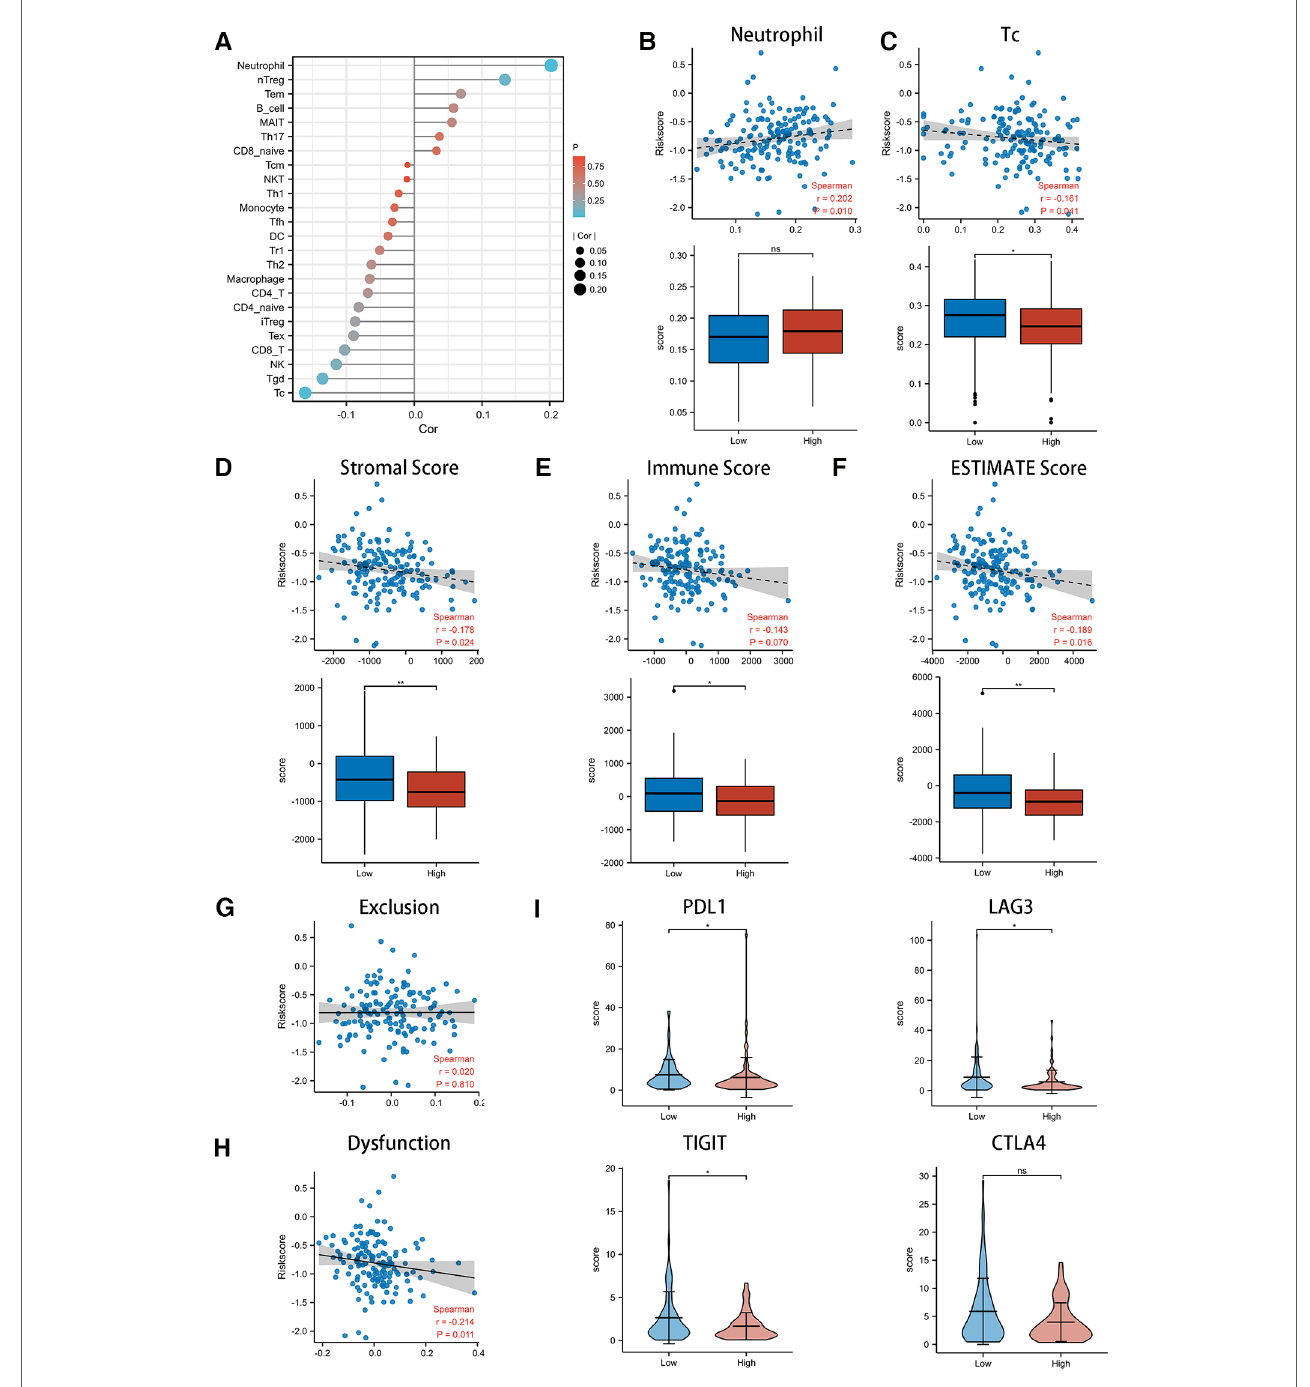
FIGURE 5 Exploring the role of CSRS in the immunotherapy of esophageal cancer. ( A ) Correlation of CSRS with immune cell in fi ltration was performed by ssGSEA analysis. High CSRS group were in fi ltrated by more neutrophil ( B ) and fewer Tc( C ). Relationship between scores with CSRS, as well as comparison of scores between high- and low-CSRS group in stromal ( D ) score, immune ( E ) score and ESTIMATE ( F ) score. Relationship between exclusion ( G ) and dysfunction ( H ) scores with CSRS. ( I ) Comparison of checkpoint genes, including PDL1, LAG3, TIGIT and CTLA4, between high- and low-CSRS groups. ns: no signi fi cance; *: p <0.05; **: p